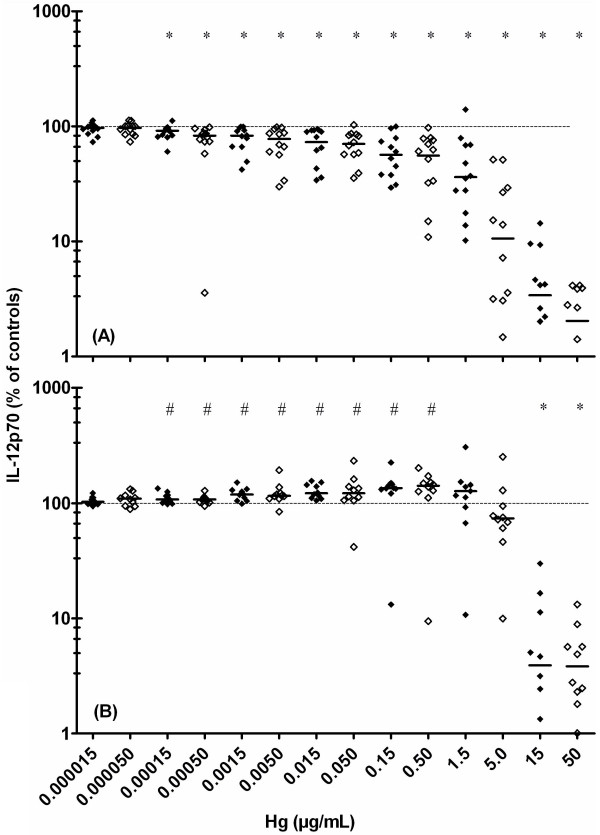
Levels of IL-12p70 released by human PBMC exposedto HgCl2 for 24 hr. Cells were stimulated either by mAb (anti-CD3/anti-CD28/anti-CD40) (A) or hkSE (B). Data represent the values of 12 and 10 donors in both panels respectively; the horizontal lines represent the medians. Symbols above each plot show whether, cytokine release was significantly stimulated (#) or suppressed (*) compared to the controls (Wilcoxon's Rank Sum test for paired samples; p < 0.05).